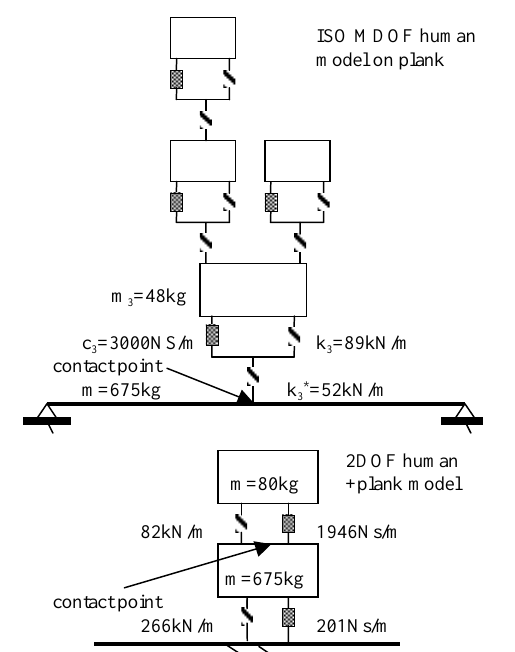
Fig. 6. Equivalent multi-degree of freedom (MDOF) systems for human and human-plank system. Forces between human and plank are transmitted at the indicated contact point.